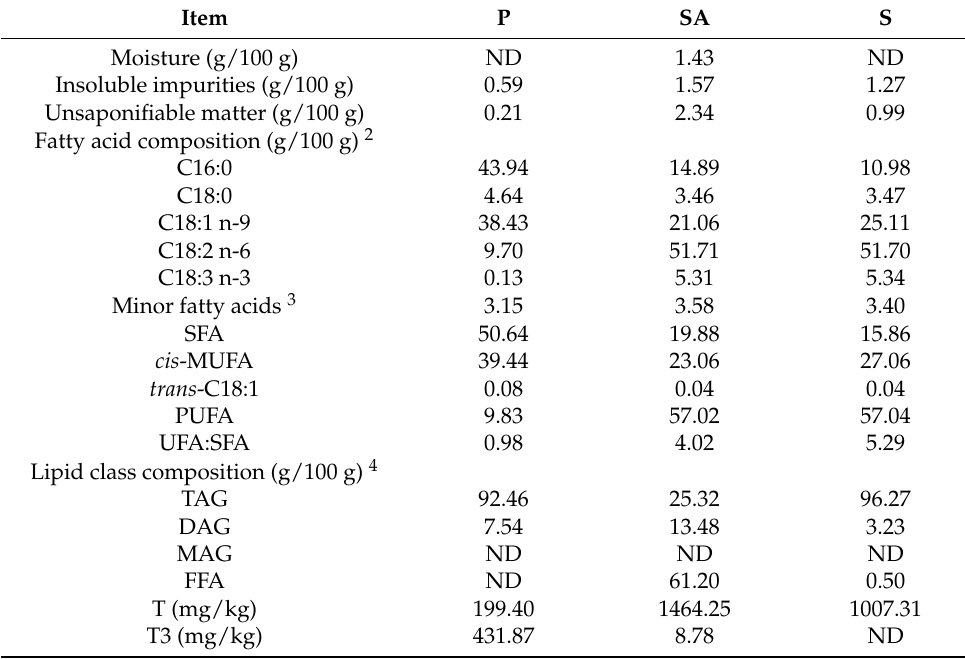
Table 1. Chemical analyses of the experimental fats 1 .